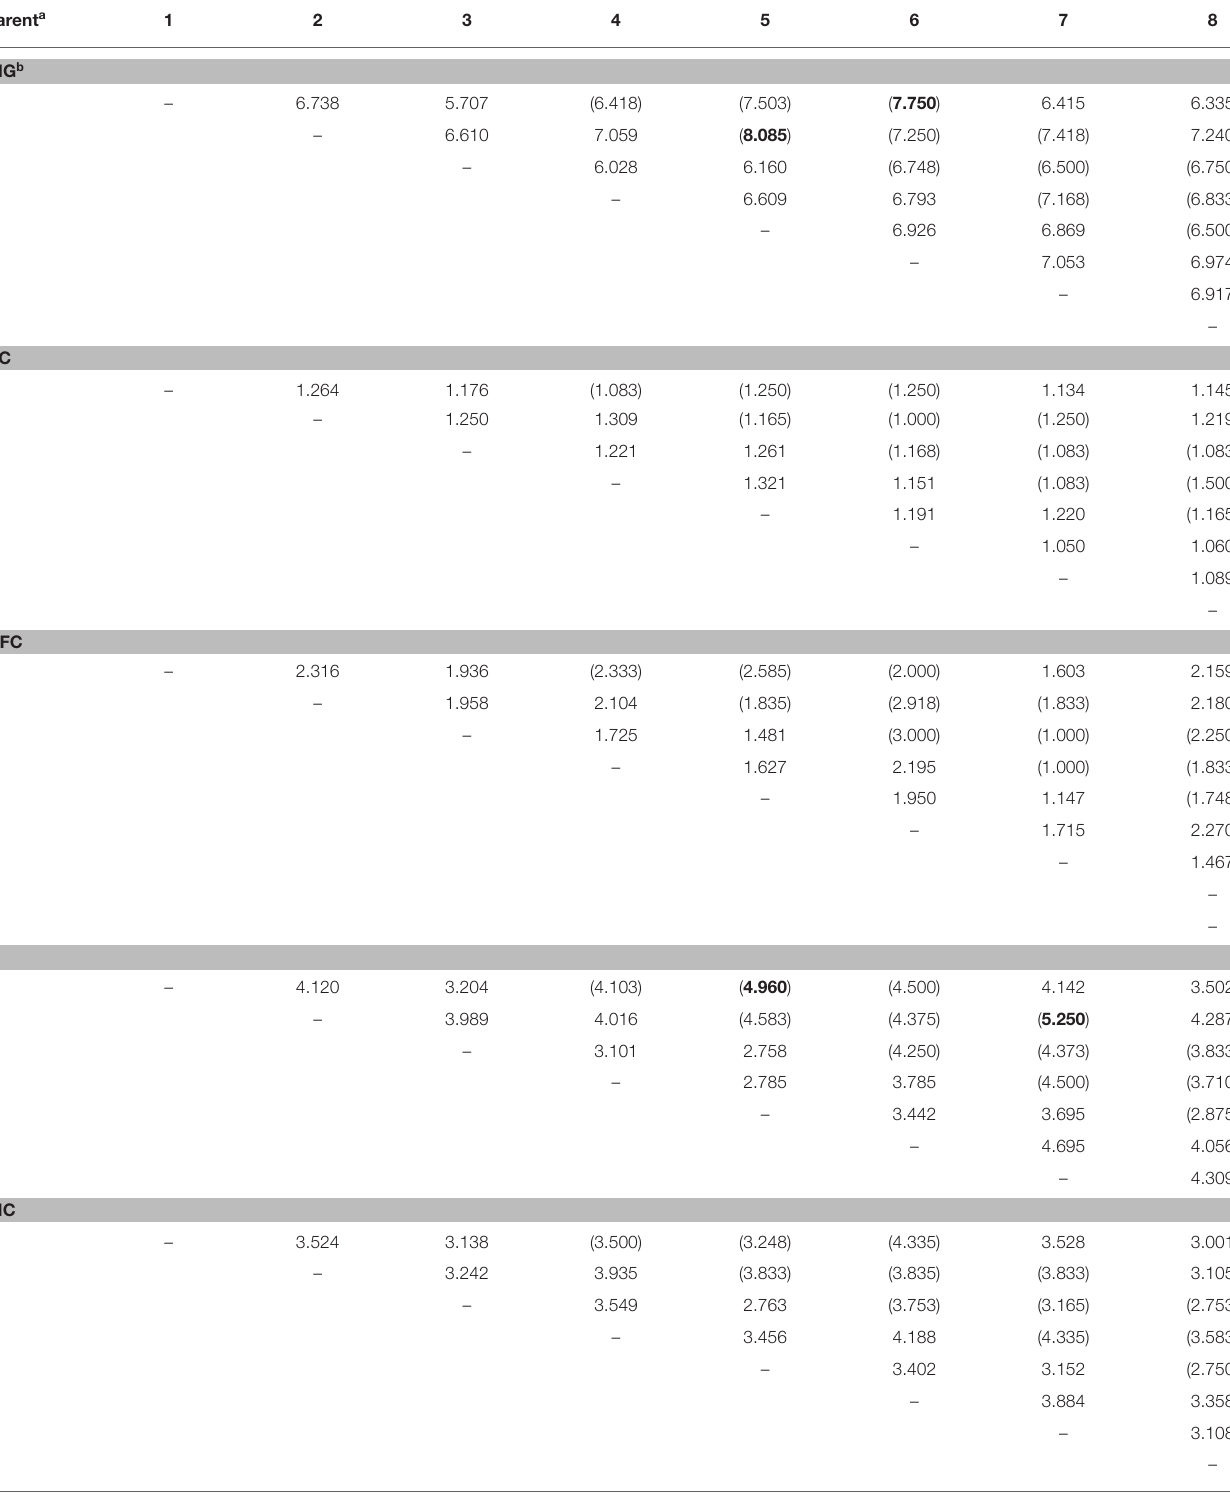
TABLE 9 | Hybrid means (in parentheses) and predicted mean values of the hybrid not included in the circulating diallel analysis for 10 agronomic traits. Parent